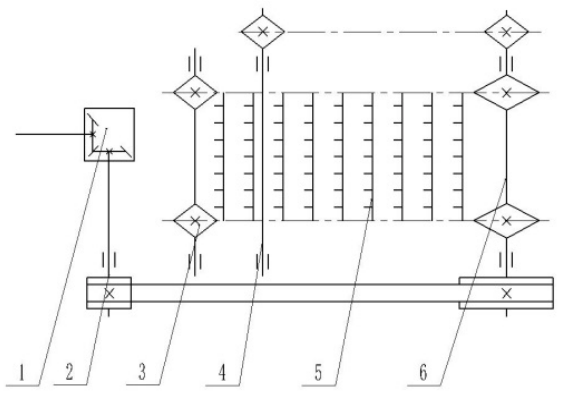
Figure 2. Schematic diagram of the powertrain system of a chain drive film-soil separation mechanism. 1 gearbox; 2 output shaft; 3 driven chain gear shaft; 4 jogging roller shaft; 5 chain rod, and 6 active chain gear shaft.